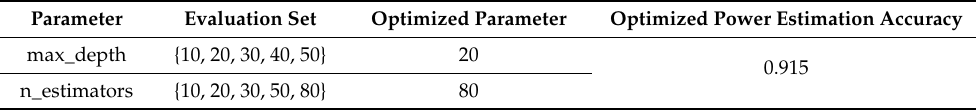
Table 8. Model parameters selection and optimized performance for the MTR model.